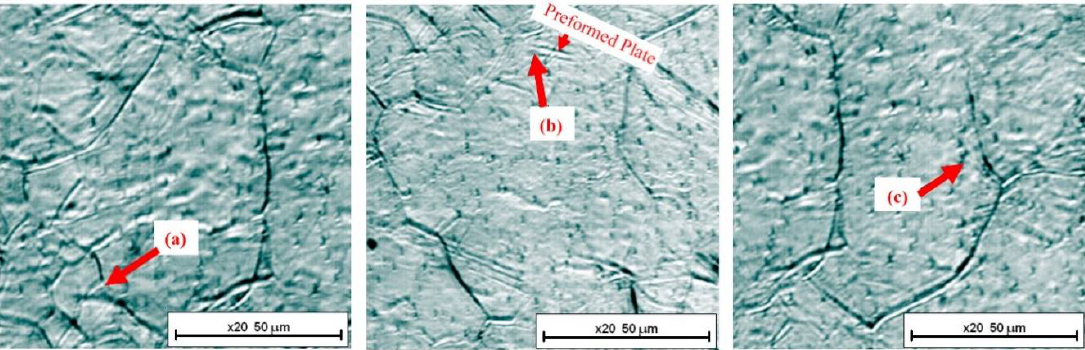
Figure 2. Bainite plate nucleation observed at three distinct locations: ( a ) on grain boundaries (GB); ( b ) on preformed bainite (OP) and ( c ) inside the grain (IN).